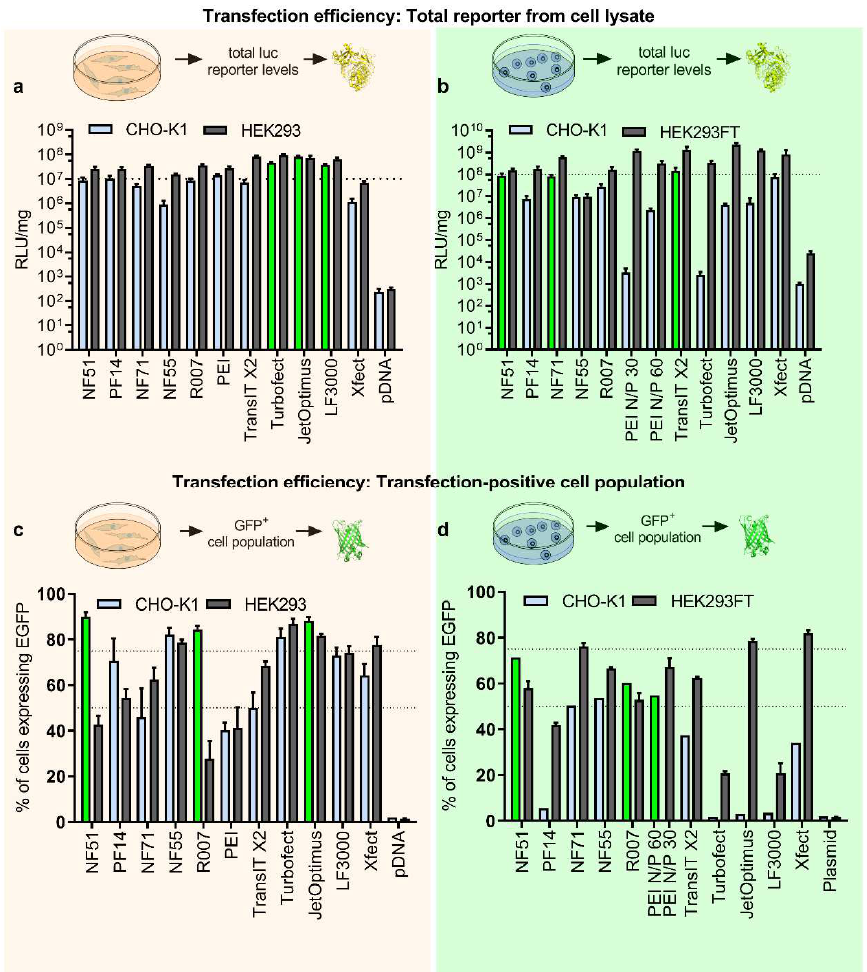
Figure 2. Suspension culturing improves the predictability of protein production. ( a ) Adherent cells were transfected with 0.2 µg of pLuc per 96-well plate well. CPP/pDNA complexes were formed at CR3:1, and PEI complexes were formed at N/P20. The total reporter levels were determined 24 h post-transfection. N = 10 for treatment groups. ( b ) The suspension cells were transfected with 0.1 µg of pLuc per 96-well plate well. CPP/pDNA complexes were formed at CR2:1. Total reporter levels were determined 48 h post-transfection. N = 10 for treatment groups. ( c ) Adherent cells were transfected in serum-free media with 0.5 µg of green fluorescent protein encoding plasmid (pGFP) per 24-well plate well. 4 h post-transfection media was changed to serum-containing media. CPP/pDNA complexes were formed at CR3:1, PEI N/P20. Analysis was performed 24 h post-transfection. N ≥ 5. ( d ) Suspension cells were transfected in serum-free media with 0.75 µg of pGFP per 24-well plate well. CPP/pDNA complexes formed at CR2:1. For PEI N/P20 was used in case of the HEK293FT cells and N/P60 in case of CHO-K1 cells. 4 h post-transfection 500 µL of fresh media was added to each well. 48 h post-transfection the cells were analyzed by flow cytometry. N ≥ 6 for treatment groups.